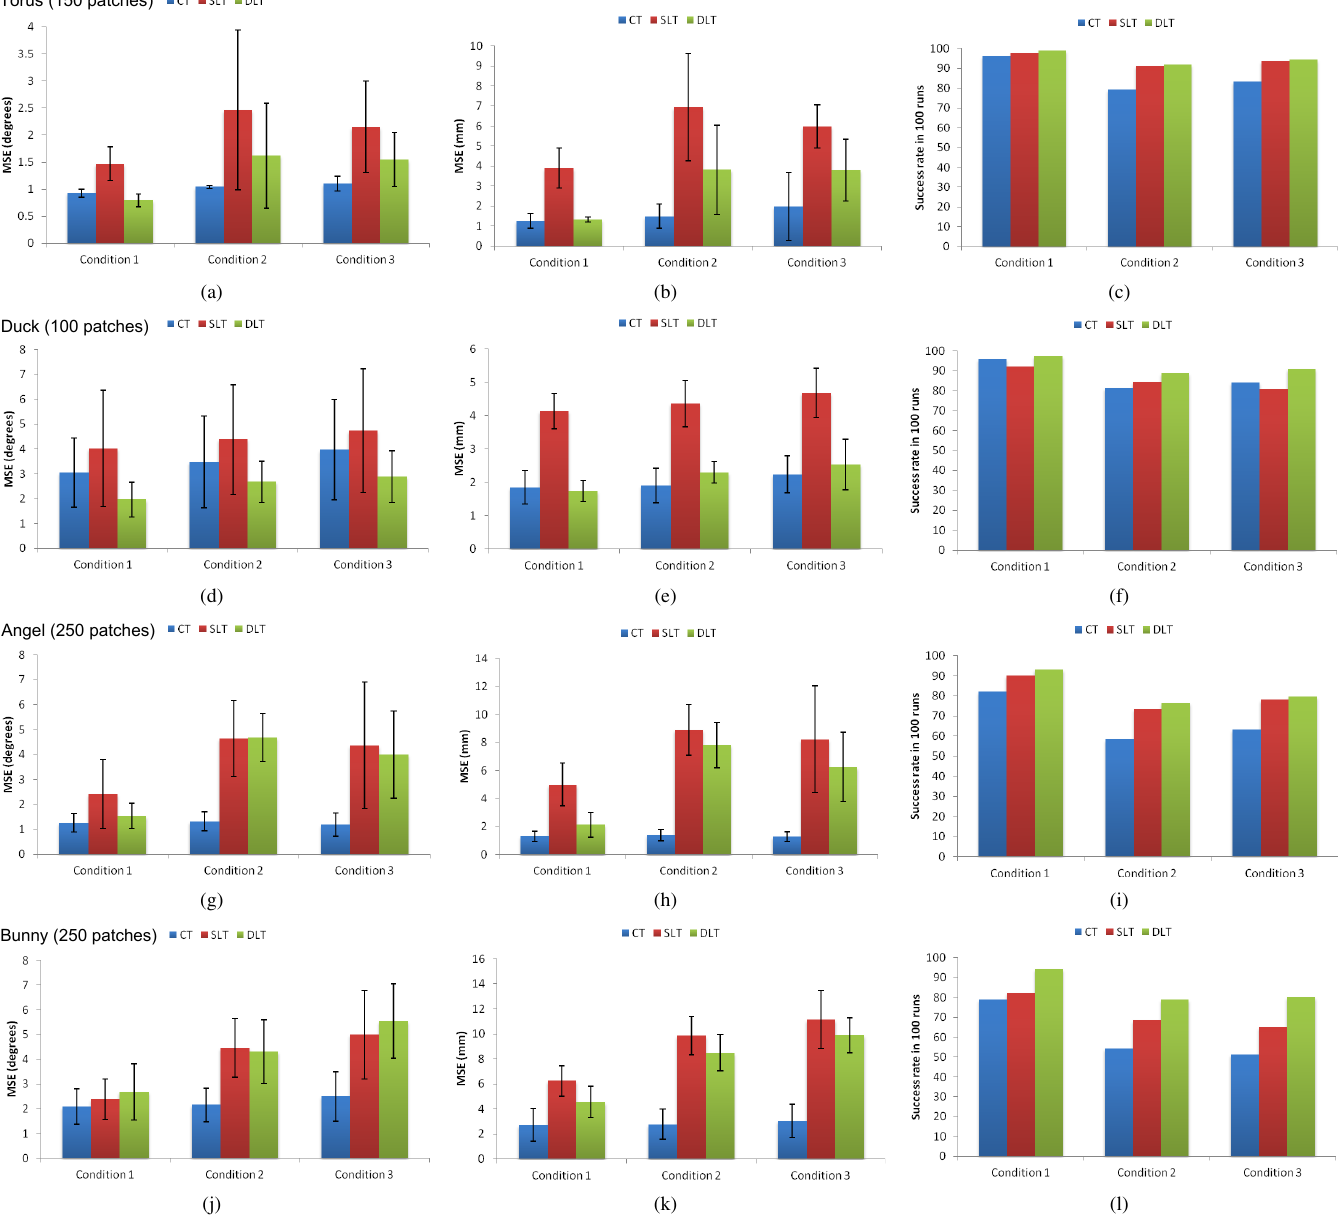
Fig. 15. Results for accuracy and success rate of experiment B. Left : MSE for the rotation in degrees. Middle : MSE for translation in mm. Right : Average of the success rate in 100